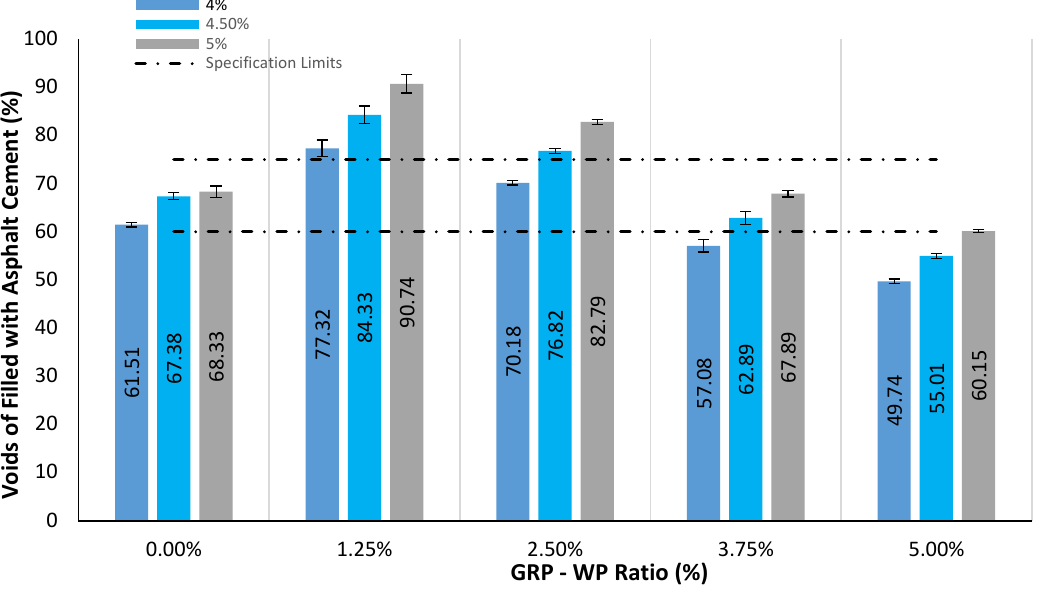
Figure 7. Comparison of VFA results for the 45 samples tested.